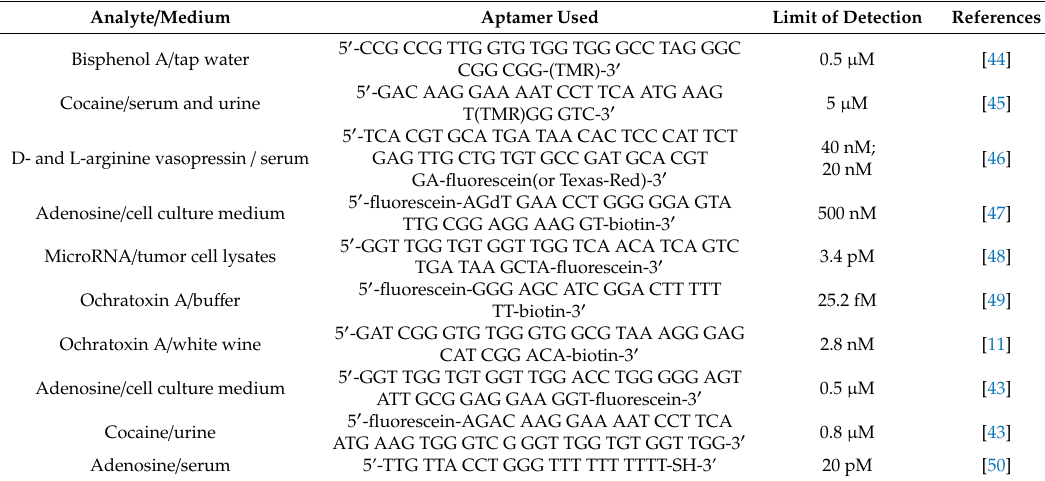
Table 1. Aptamer-based FPAs considered in this